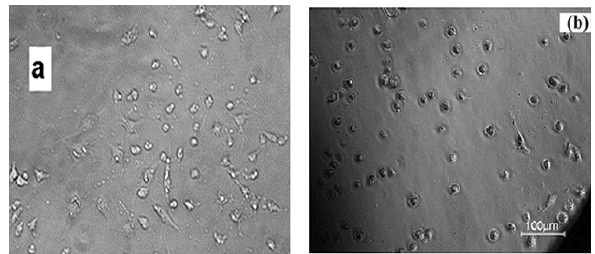
Figure 2. (a) Positive control Class-1 Image and (b) Positive Control Class-2 Image